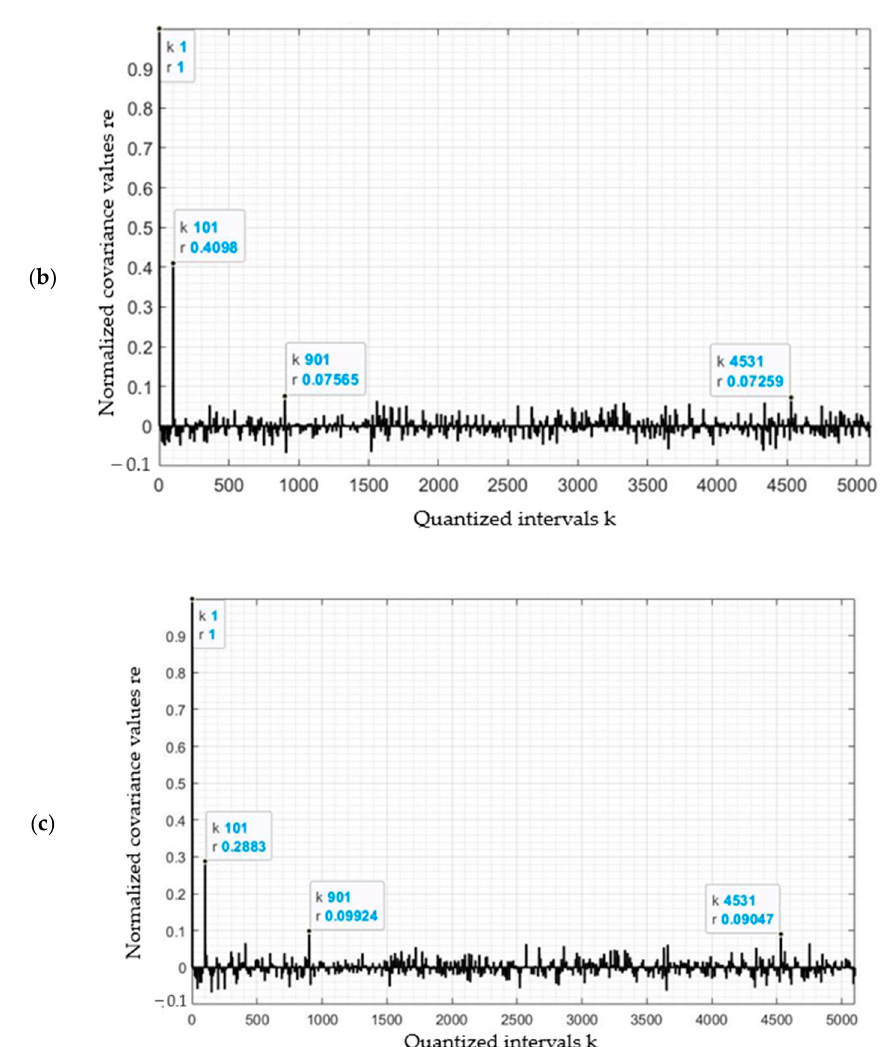
Figure 6. Pixel vector auto-covariance functions: ( a ) kfr1— H. sosnowskyi plants (shown in red in Figure 5); ( b ) kfr2—other plants (shown in green in Figure 5); ( c ) kfr3—agricultural land (shown in grey in Figure 5).